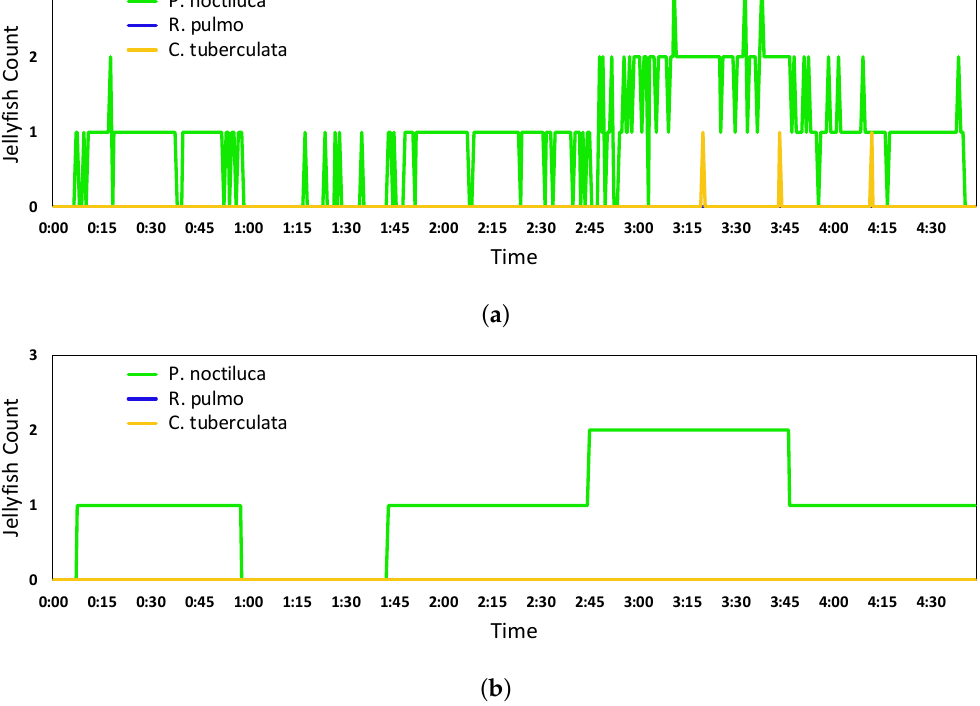
Figure 9. Results of the jellyfish count from Inception ResNet V2 final predictions ( a ) and quantification algorithm ( b ) over a video showcasing nearly 5 min of footage of up to two P. noctiluca jellyfish going in and out of the